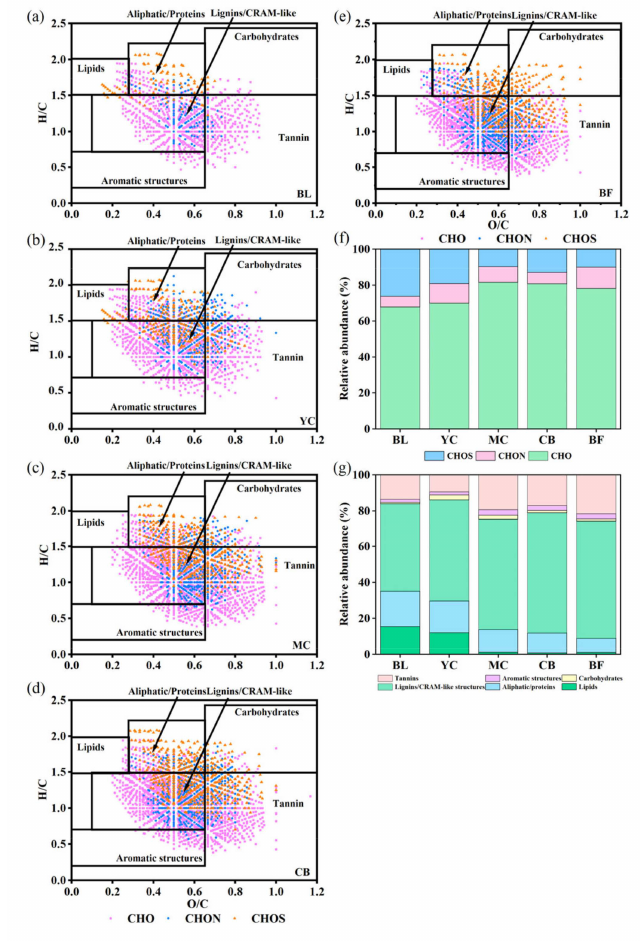
Figure 1. Van Krevelen diagrams of CHO, CHON, and CHOS subcategories in dissolved organic matter (DOM) from soils along a vegetation restoration chronosequence for bare land (BL) ( a ), newly restored young coniferous forests (YCs) ( b ), slightly more mature coniferous forests (MCs) ( c ), mixed coniferous and broadleaf forests (CBs) ( d ) and broad-leaved forests (BFs) ( e ). The black lines in the van Krevelen diagrams correspond to major classes of compounds that can be expected in DOM. Bar diagrams show the contribution of the ( f ) major subcategories and ( g ) major classes in each site. CHO: DOM molecules containing carbon, hydrogen, and oxygen atoms; CHON: DOM molecules containing carbon, hydrogen, oxygen, and nitrogen atoms; CHOS: DOM molecules containing carbon, hydrogen, oxygen, and sulfur